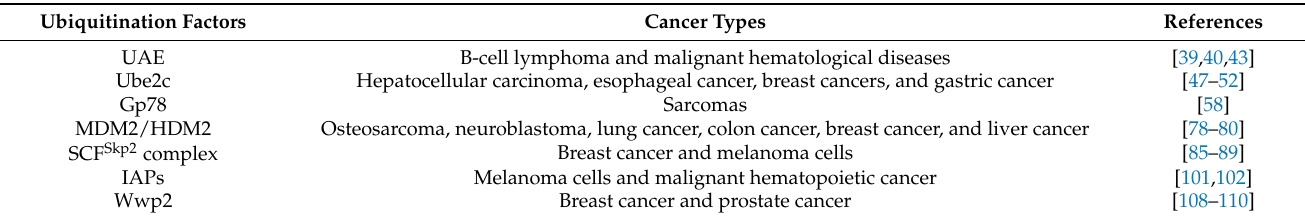
Table 1. Ubiquitination factors involved in cancer